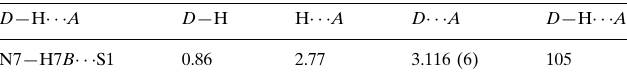
Hydrogen-bond geometry (A˚ , (cid:1)